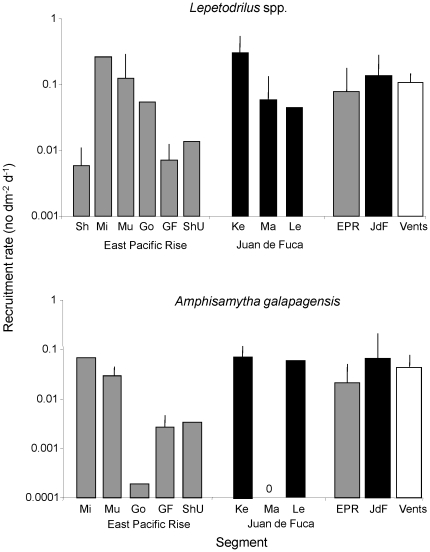
Rate of recruitment (+SD) of two dominant taxa at vents.The taxa are the gastropod genus Lepetodrilus and the polychaete Amphisamytha galapagensis, shown for different studies at the Juan de Fuca Ridge (JDF)and East Pacific Rise (EPR), as well as averaged across studies for each segment and across both segments for the vent habitat. EPR: Sh = [11]; Mi = [31]; Mu = [30]; Go = [13]; GF = [19]; ShU = Shank unpublished data; JDF: Ke = [10]; Ma = [12]; Le = Levin unpublished data.